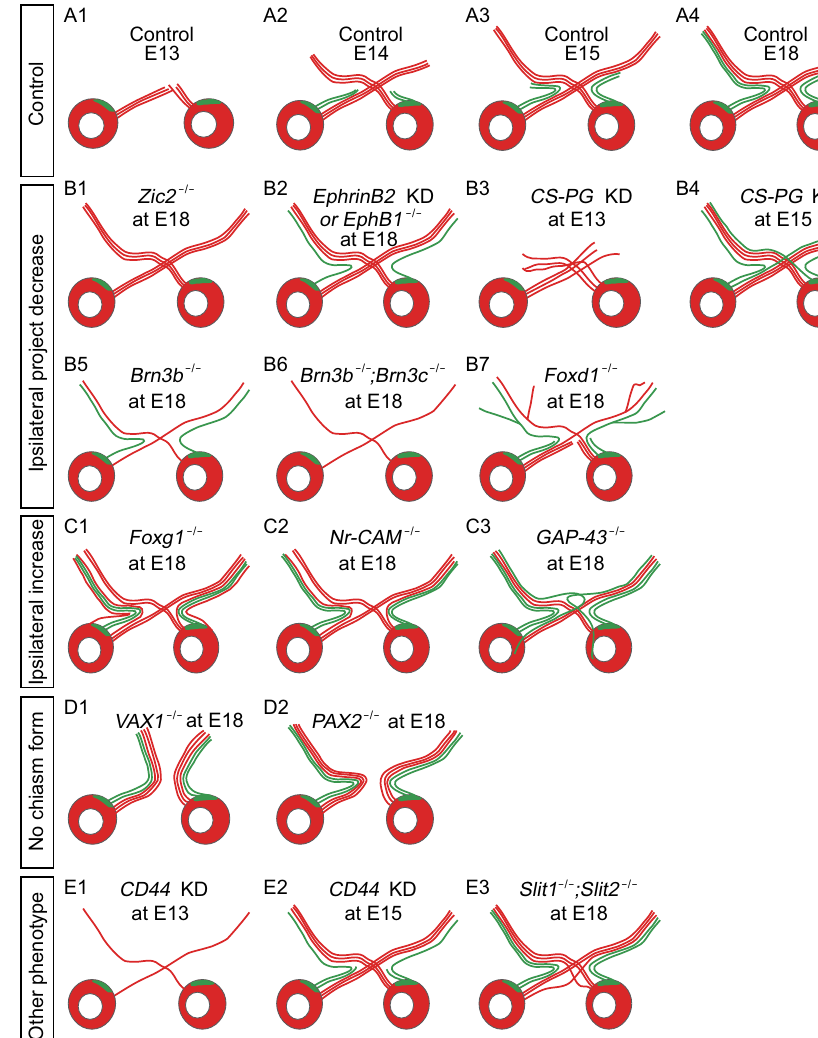
Figure 1. Schematics of genes and molecules involved in the path fi nding of RGCs axon at the optic chiasm. (A1 – 5) Normal development of RGCs axon path fi nding at the optic chiasm. (B1 – 7) Molecules lead to ipsilateral projection reduction at the optic chiasm in mice. (C1 – 3) Increase of ipsilateral projections at the optic chiasm. (D1 – 2) No optic chiasm formation in the VAX1 and PAX2 knockout mice. (E1 – 3) Some other phenotypes observed at the optic chiasm in different mice